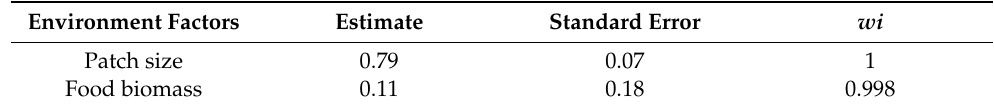
Table 2. Model-averaged parameter estimate, standard error, and relative importance (Akaike weight , wi ) for important variables.